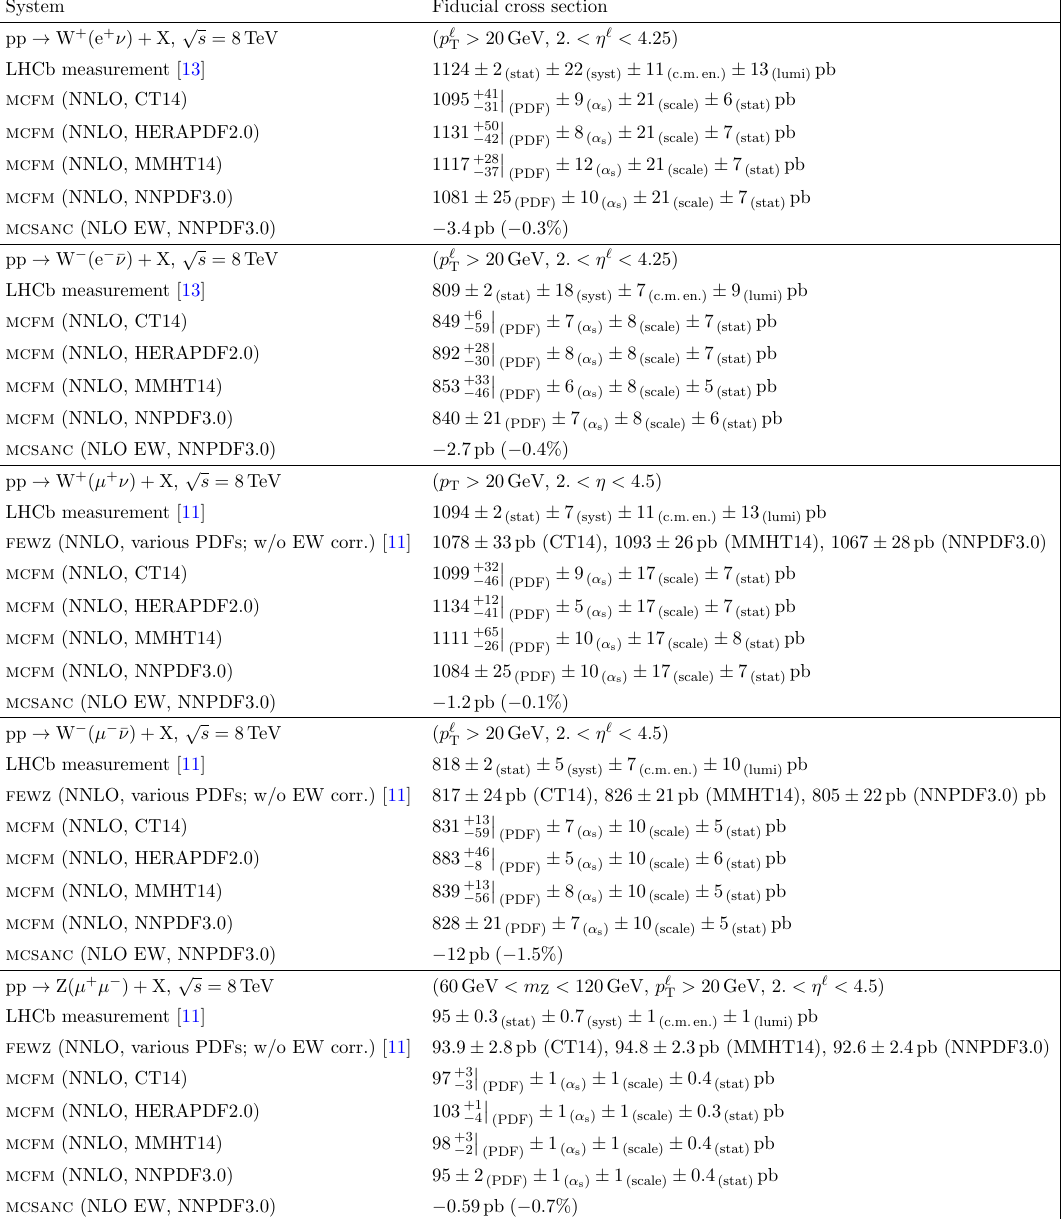
Table 8 . Comparison of the LHCb (cid:12)ducial cross sections for W + , W (cid:0) , and Z boson production p in pp collisions at s = 8 TeV to the NNLO pQCD results obtained with mcfm using the CT14, HERAPDF2.0, MMHT14, and NNPDF3.0 PDF sets, including NLO EW corrections computed with mcsanc (also listed independently in the last row). Alternative fewz NNLO results (without EW corrections) quoted in the original LHCb works are also given for comparison. In all plots of (cid:12)gures 1{3, the points where the (cid:12)lled ellipses cross the vertical dashed line at (cid:11) ( m ) = 0 : 118 indicate the most likely cross section interval that would s Z